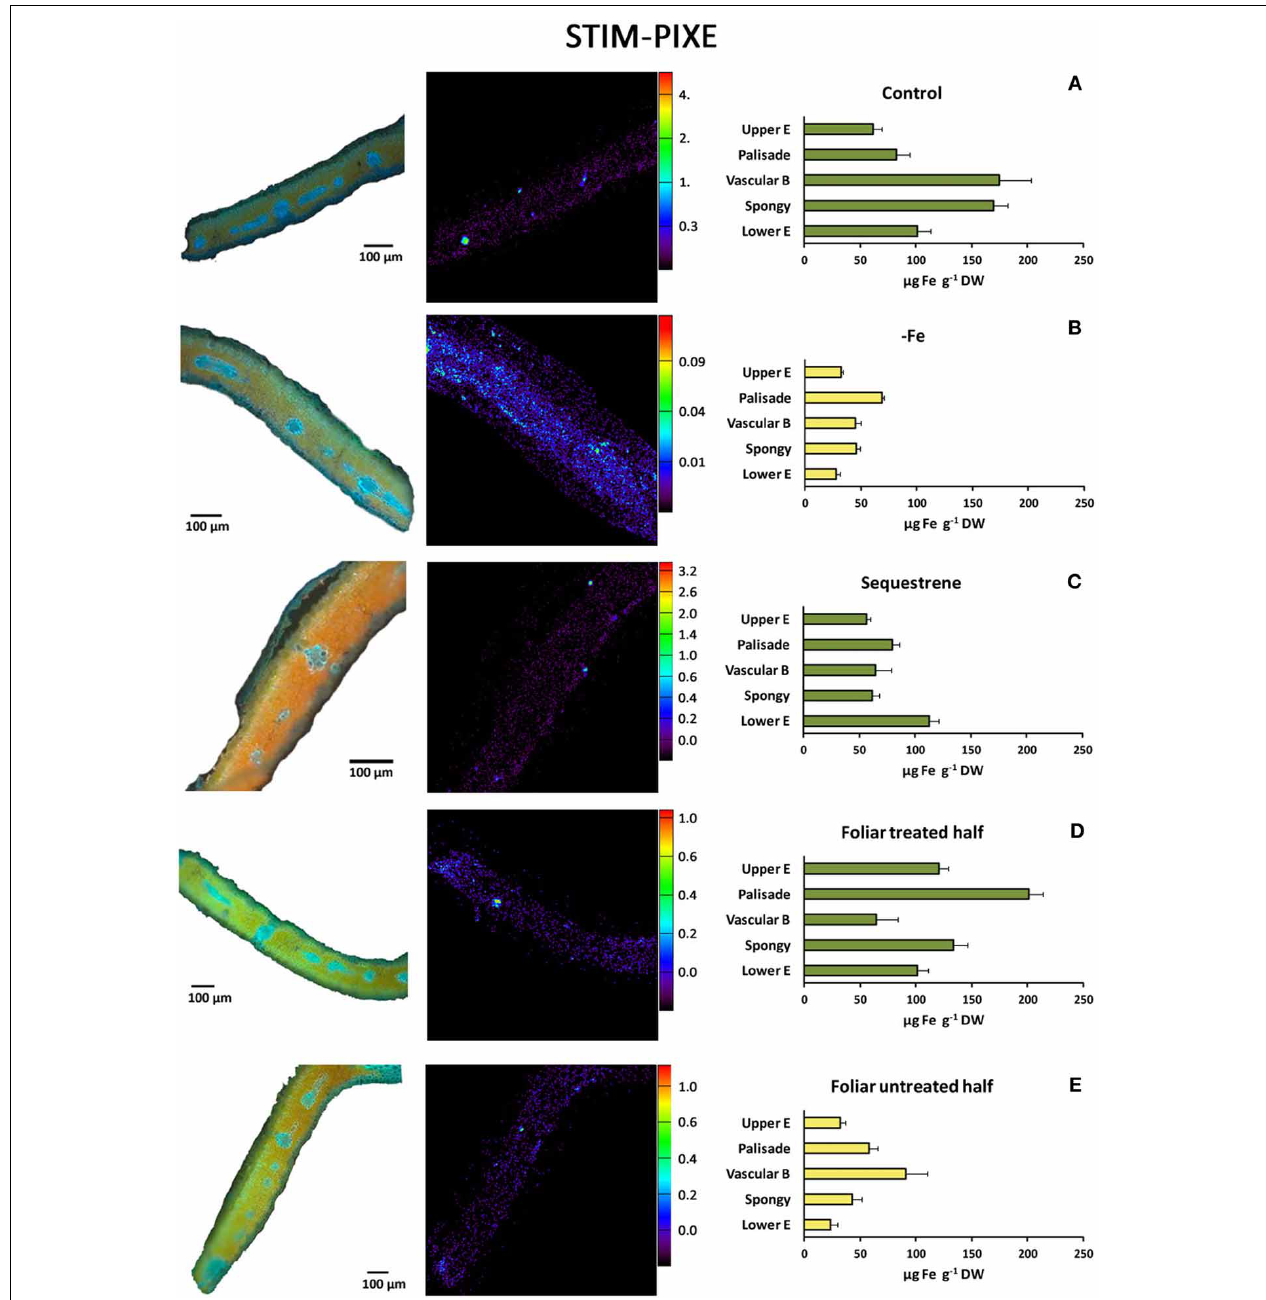
FIGURE 7 | STIM μ -PIXE mapping and quantitative analysis of Fe (right panels) of selected areas from transversal sections of peach tree leaves. (A) Fe-sufficient control; (B) Fe-deficient chlorotic; (C) soil Fe-fertilized